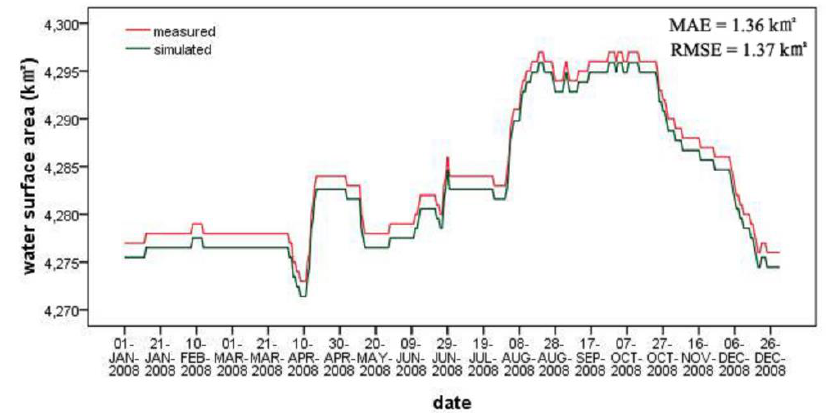
Figure 12. Time series of the estimated water surface areas versus measurements in the year 2008. The green line represents the surface areas estimated by using the L-A curve established in Figure 6 and the water level observations at Xiashe station as inputs.